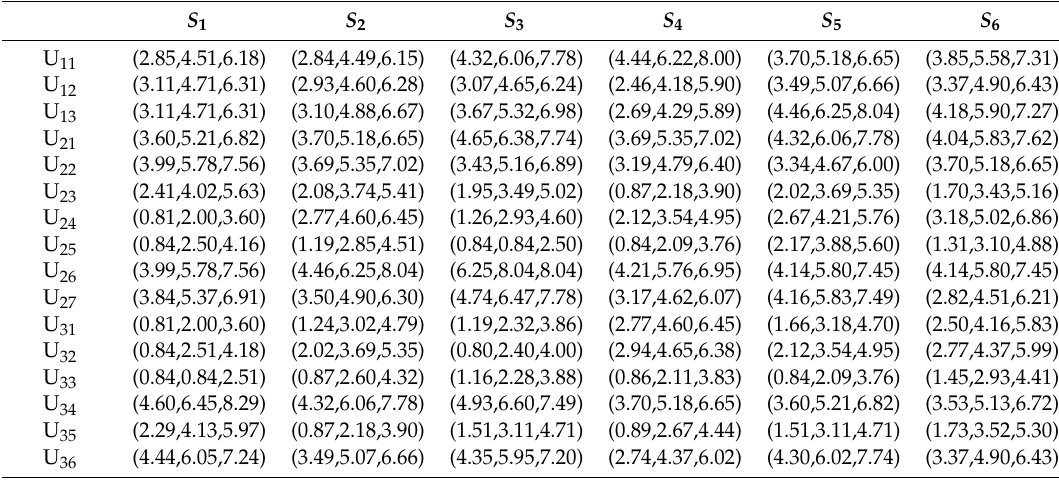
Table A1. The fuzzy decision